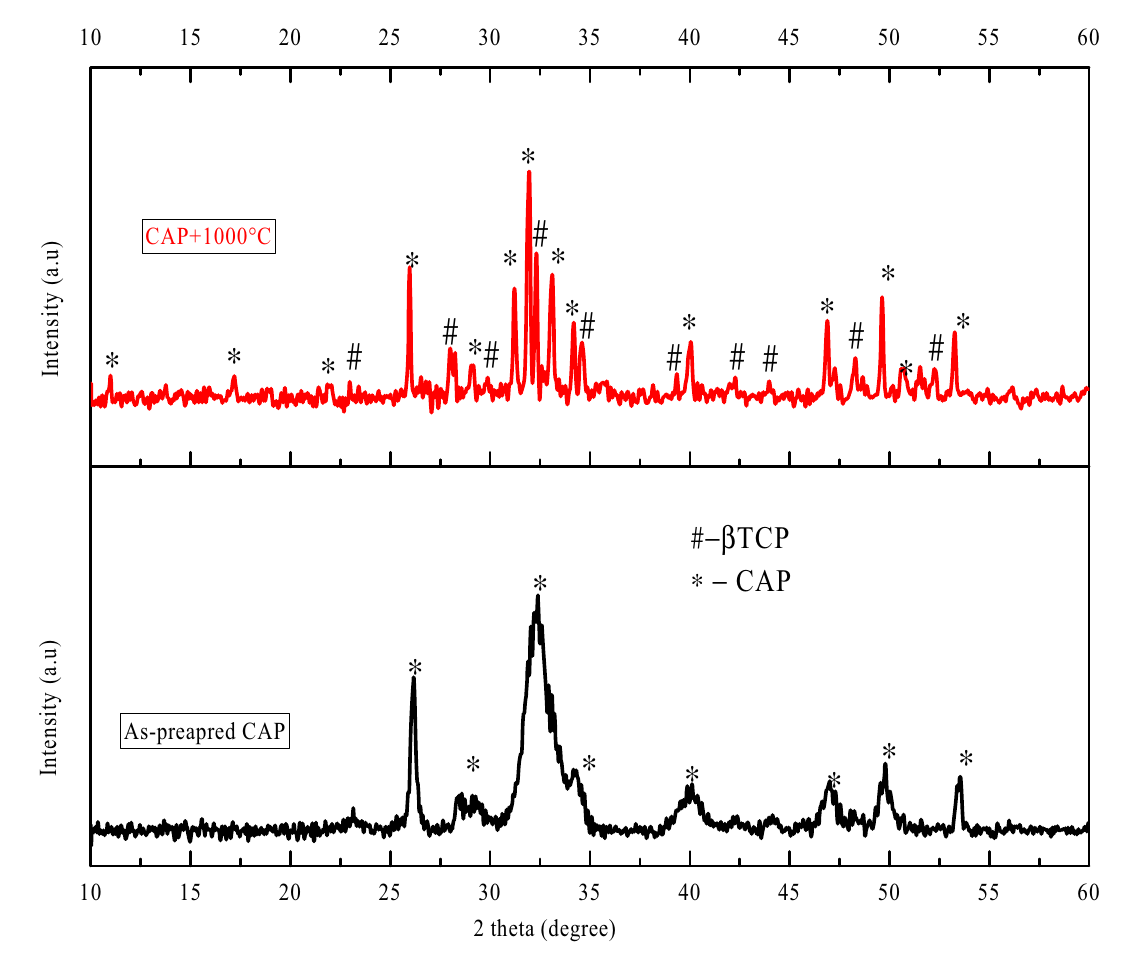
Fig. 3 XRD analysis of as-prepared carbonated apatite and heat treated carbonated apatite at 1000